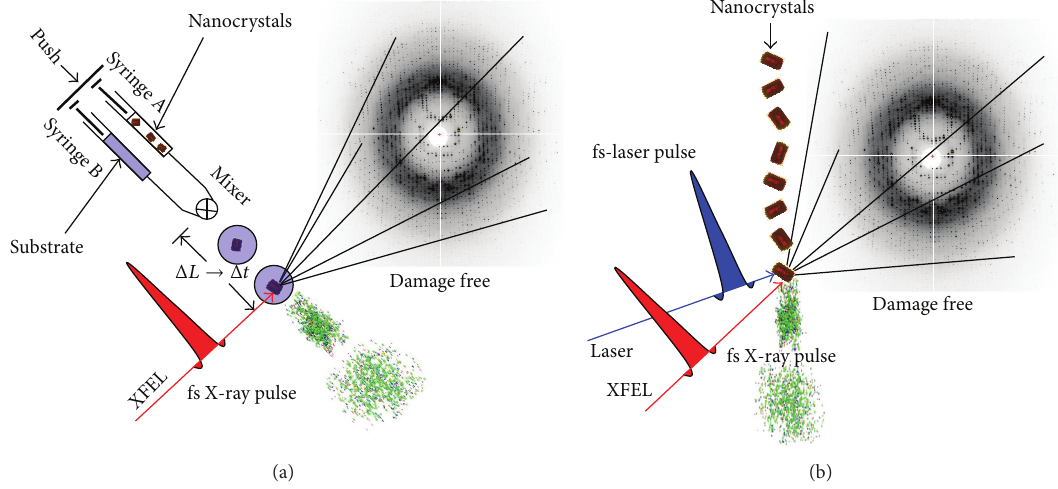
Figure 2: (a) Schematic setup for a mix and inject time-resolved femtosecond serial crystallographic experiment at the XFEL. Nano- and microcrystals are in syringe A and substrate in syringe B. After mixing, the crystal/substrate droplet is injected into the XFEL beam. The crystal might disintegrate after the fs X-ray pulse, but diffraction occurs earlier. The diffraction pattern is damage free. (b) Time-resolved pump-probe experiment with serial femtosecond crystallography. Setup can be used to stimulate photoreceptors for photoflash experiments or to activate caged substrates. Conceptual similarities between (a) and (b) are